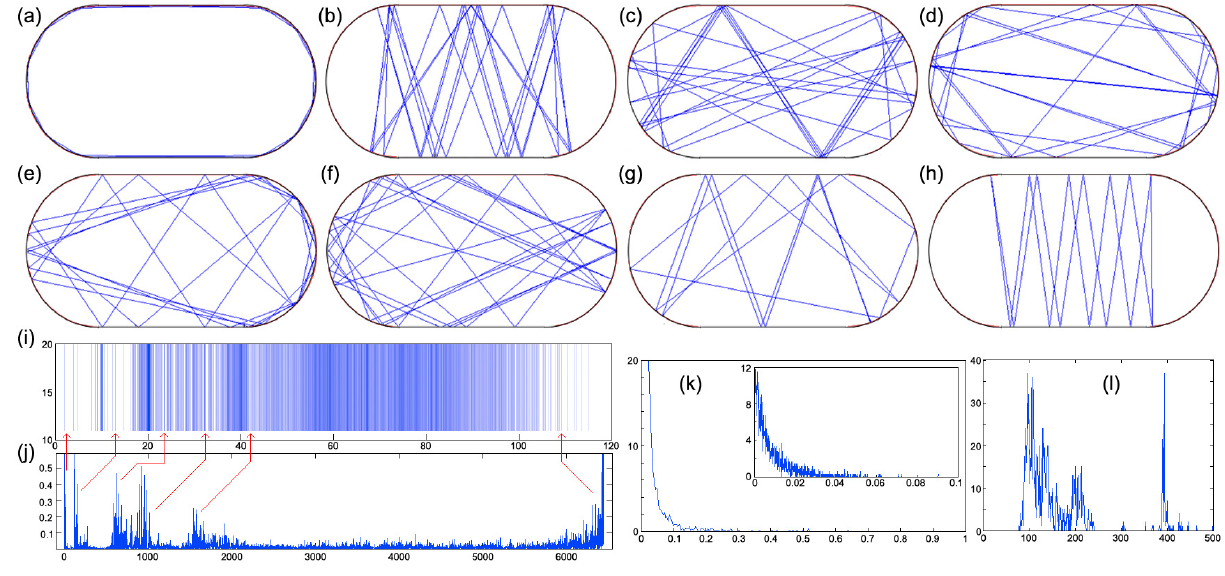
Figure 8: A collection of classical 16-step close recurrences approximating periodic repelling orbits, some with reverse orbit symmetrization to 32 steps. Repelling orbits symmetric by horizontal reflection (a, b), symmetric by a rotation by 180 degrees (c, d), symmetric by vertical reflection (e, f), and asymmetric (g, h). Supplements 3-5: Quicktime movies of symmetric period 16 orbits passing through (0,0), (0,1) or (2,0). (i) Distribution of lengths of 6444 close orbit recurrences of up to 20 reflections generated from positions (0,0), (2,0) and (0,1), having rotational and reflective symmetry shaded to give relative densities. (j) Corresponding distribution of orbit length di ff erences of the ranked length array. The right hand peak is an artifact caused by missing orbits with higher reflection numbers. (k) Distribution of length di ff erences by frequency shows a descending law in which larger gaps are rarer. This pattern is repeated in the inset when the outliers are removed by choosing only the values from 2000 to 5000. This distribution di ff ers markedly from the distribution of primes (see panel (e) of Figure 11) and is unlikely to be an artifact of the orbit selection because it is clear there are sequences of orbits with orbit lengths converging in the limit, such as those exemplified in (a), which tend asymptotically to the circumference of the stadium. According to the trace formula given by Equation 1 the phase shifts and sensitivity of the orbits also have to be included before a GUE distribution is arrived at, however, as shown in (l) a roughly GUE distribution, with prominent outliers corresponding to the shortest groups of orbits, does arise when the inverses of the orbit lengths are taken as a measure of